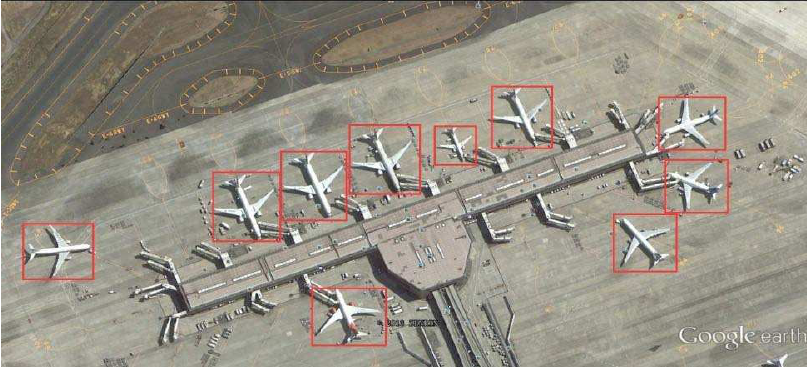
Figure 3. The annotation method of the airplane